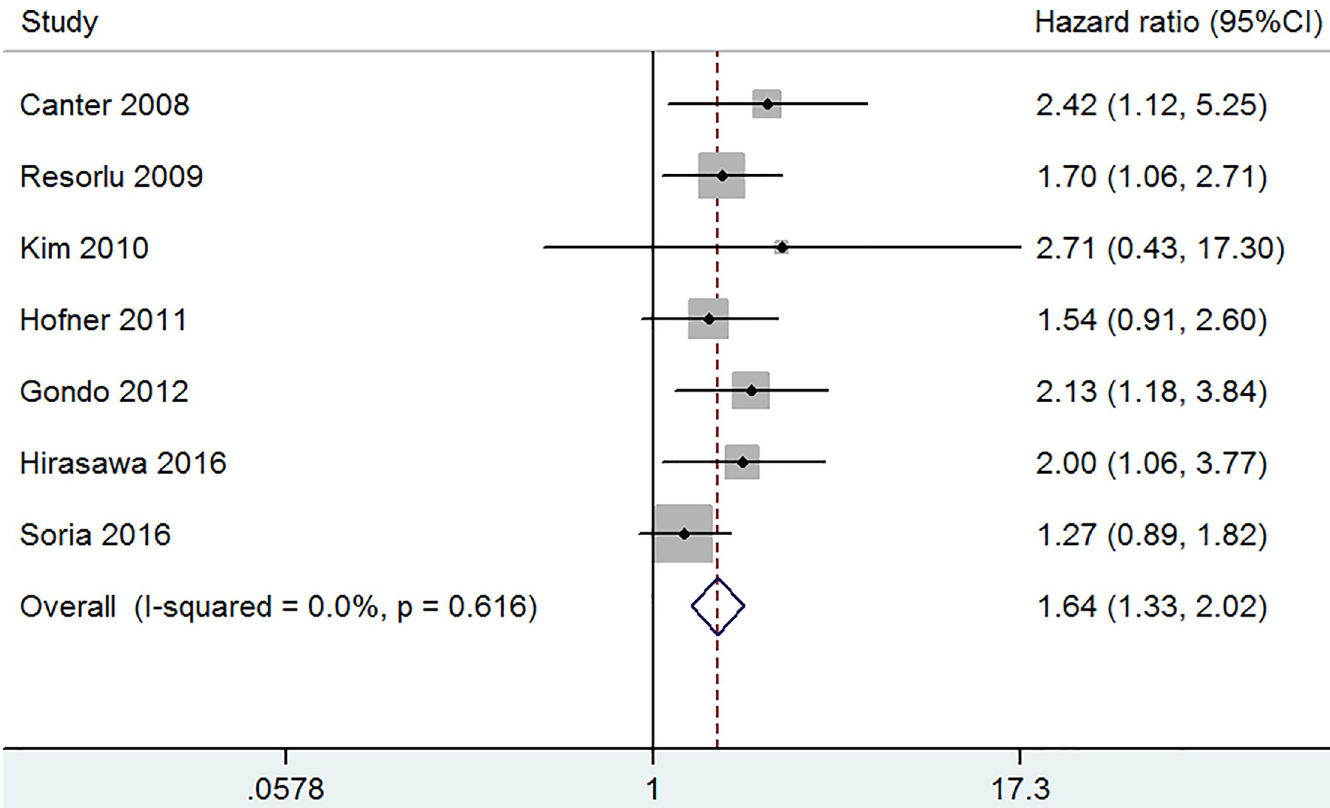
Fig 3. The hazard ratio (HR) of preoperative hydronephrosis associated with CCS in bladder cancer patients.